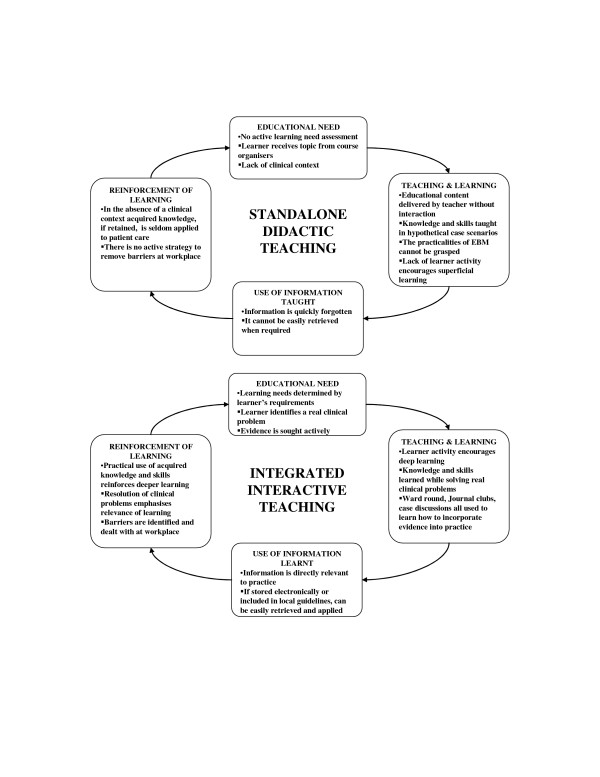
Reasons why clinically-integrated-interactive teaching may achieve better outcomes in comparison to standalone-didactic teaching.